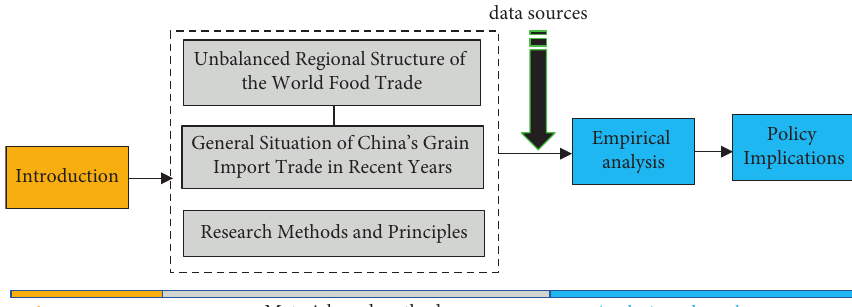
Figure 1: Research framework of the paper.